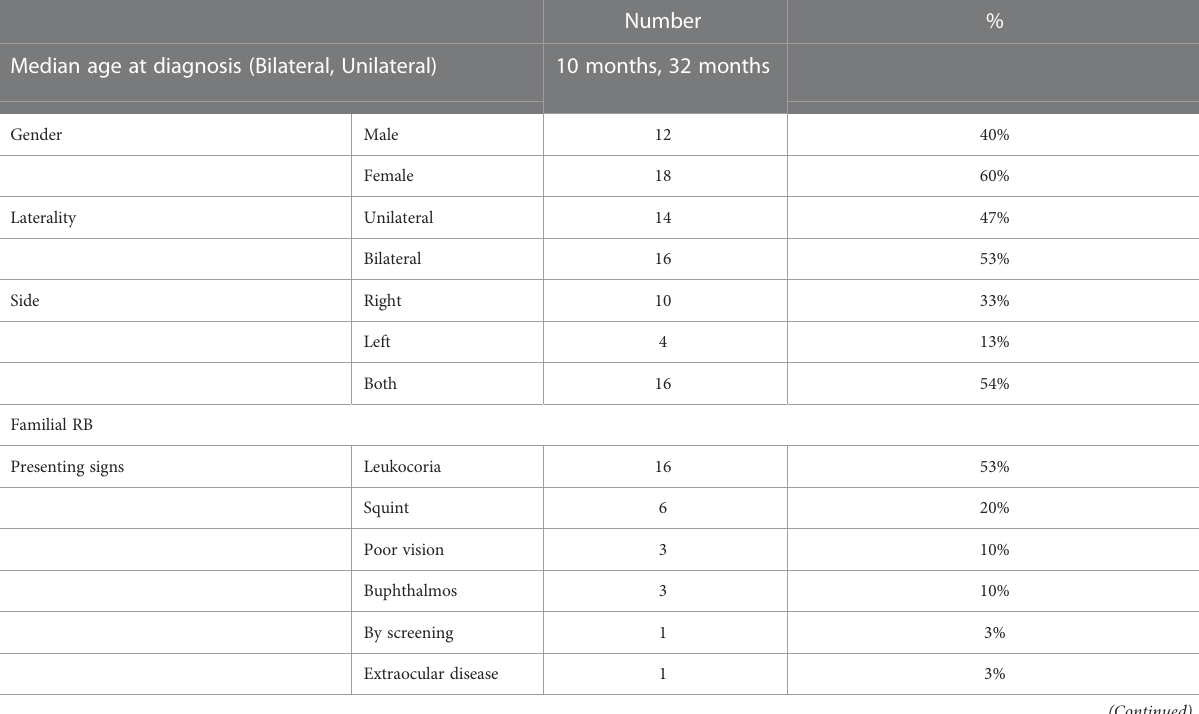
TABLE 1 Demographics, Tumor features, and management outcomes for 30 Syrian refuges with retinoblastoma treated between 2011-2020. Number % Median age at diagnosis (Bilateral, Unilateral) 10 months, 32 months